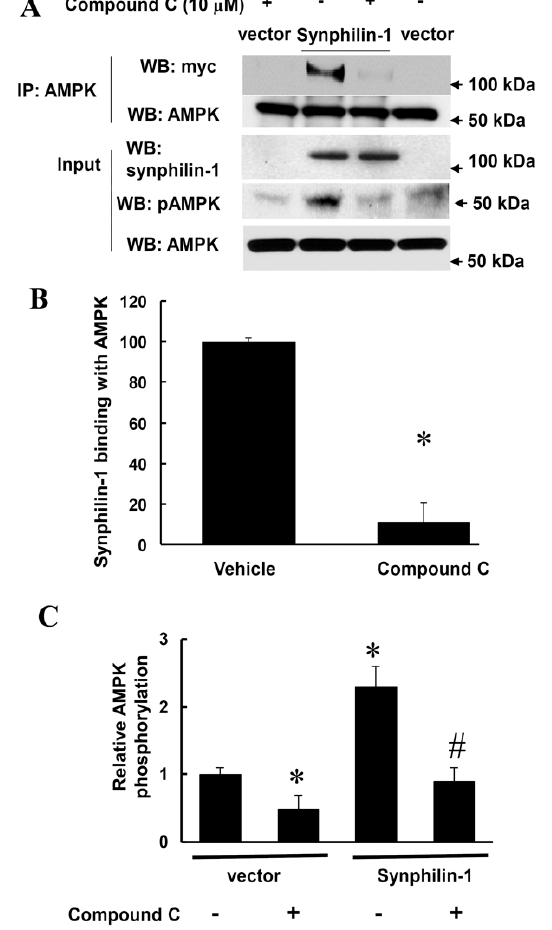
Figure 5. Compound C reduced synphilin-1 binding with AMPK. HEK293 cells were transfected with myc-synphilin-1 and vector, and treated with compound C (10 µ M) or vehicle for 48 h. Cell lysates were subjected to co-IP using anti-AMPK α antibodies. IP samples and input cell lysates were subjected to Western blot analysis using anti-myc, anti-synphilin-1, anti-phospho-AMPK α , and anti-AMPK α antibodies. ( A ). Representative blots. ( B ). Quantification of synphilin-1 binding with AMPK * p < 0.05 by ANOVA followed by Tukey’s post-hoc test, vs. cells expressing synphilin-1 with vehicle treatment. ( C ). Quantification of AMPK phosphorylation levels normalized to total AMPK levels. p < 0.05 by ANOVA followed by Tukey’s post-hoc test, * vs. vector cells with vehicle treatment; # vs. cells expressing synphilin-1 with vehicle treatment.